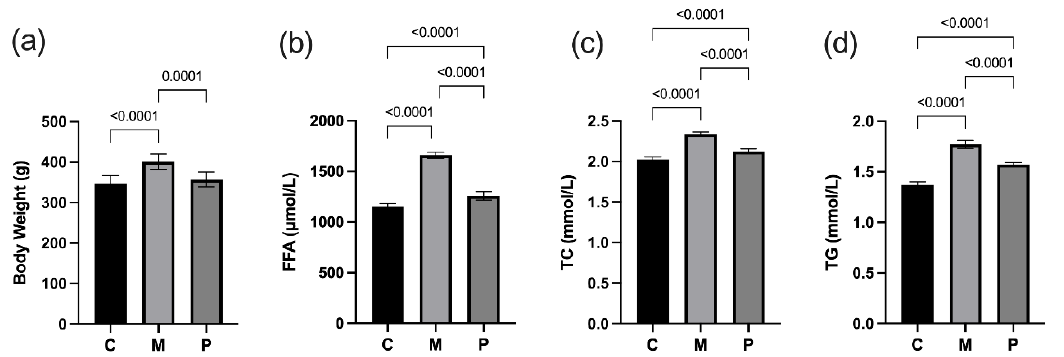
Figure 1. Lipid metabolism in rats. ( a ) Rats’ final body weight. ( b ) Serum FFA. ( c ) Serum TC. ( d ) Serum